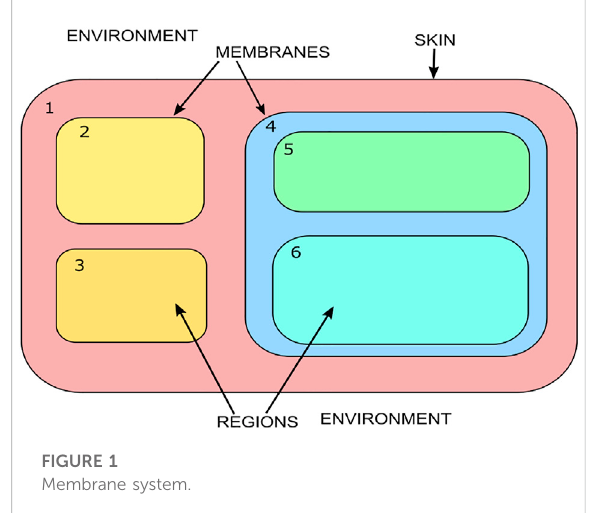
FIGURE 1 Membrane system.